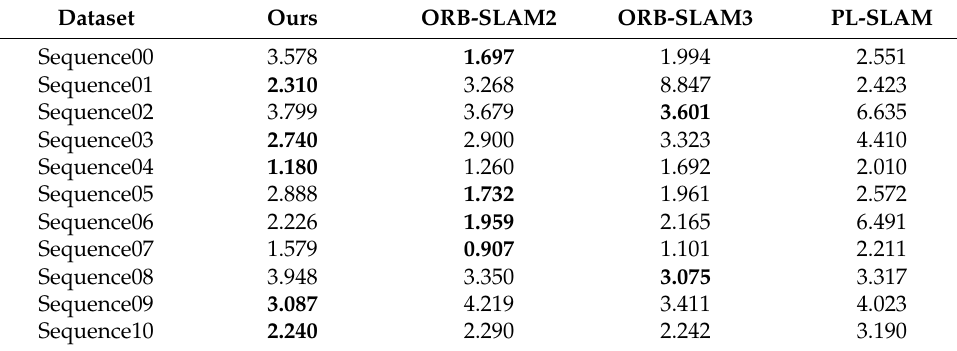
Table 2. Absolute trajectory error comparison on the KITTI